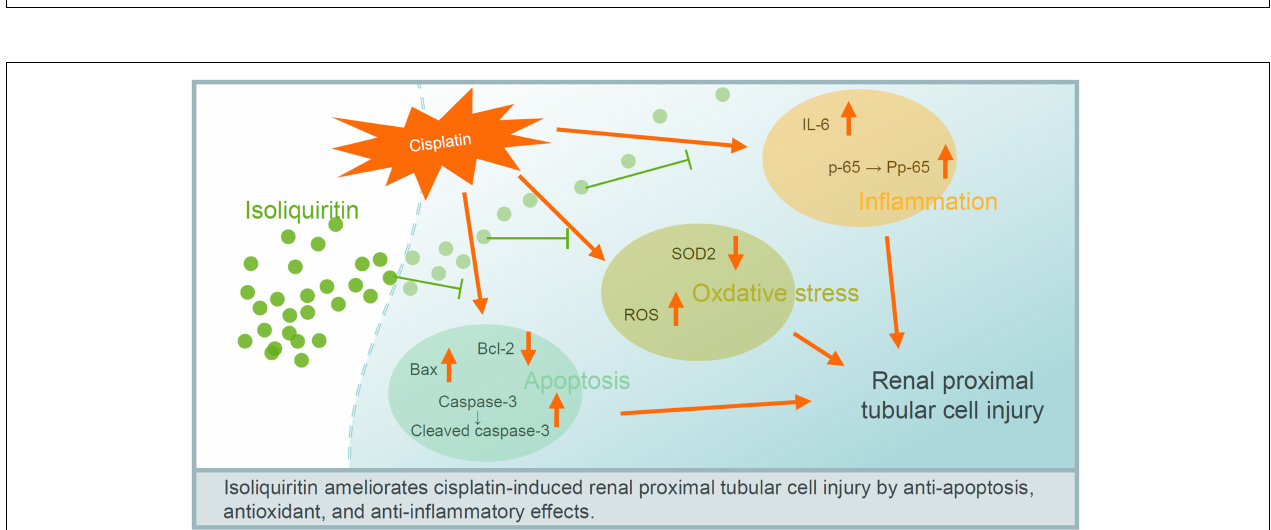
FIGURE 7 | Proposed mechanism of ISL in protecting against cisplatin-induced renal tubular cell injury. ISL attenuate cisplatin-induced renal tubular epithelial cell injury possible via antagonizing apoptosis, oxidative stress, and inflammation.